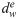
Results of the three pool method.Comparison of reconstructed results estimated with 15 and 7 b-value DWIs in the first imaging slice of the brain. (a) extracellular volume fraction α, (b) extracellular mean diffusivity dwe, (c) intracellular diffusivity dwi, and (d) low-frequency mean conductivity σL. The 3-rd and 6-th columns show the absolute values of difference between the corresponding results with 15 and 7 b-value DWIs, respectively.